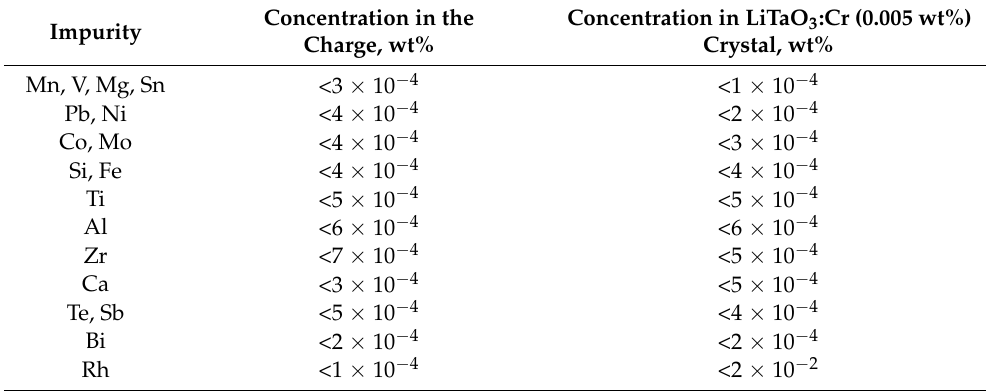
Table 1. Content of impurities in the charge and grown LiTaO 3 :Cr (0.005 wt%) crystal. Concentration in the Concentration in LiTaO 3 :Cr (0.005 wt%) Impurity Charge, wt% Crystal,